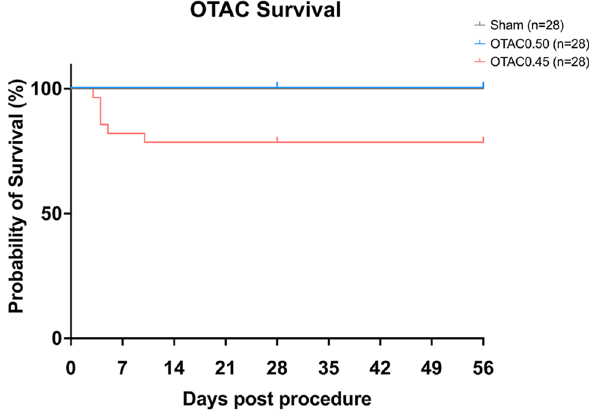
Figure 2. Kaplan–Meier survival curves for Sham and O-ring-induced transverse aortic constriction with an inner diameter of 0.50 mm (OTAC0.50) and 0.45 mm